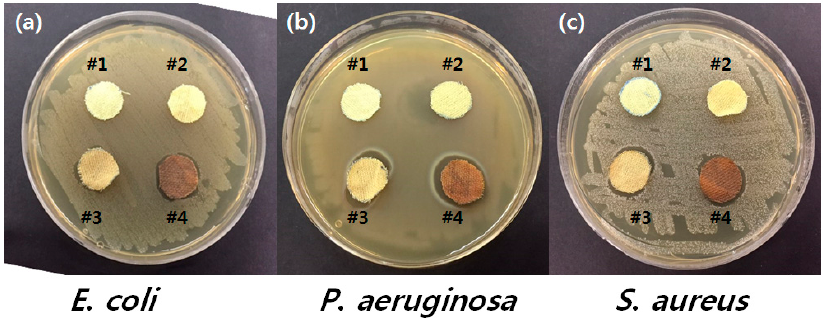
Figure 6. Antimicrobial activity of #1 untreated p -aramid, #2 p -aramid treated with GTAC, #3 p -aramid treated with AgNPs, and #4 p -aramid treated with GTAC/AgNPs.